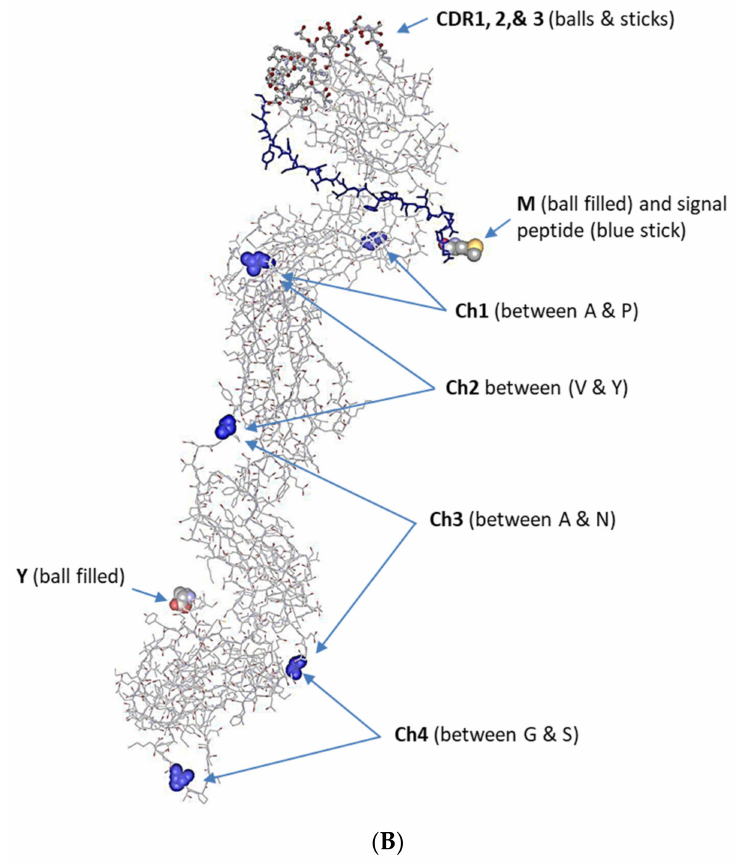
Figure 1. ( A ) Alignment of two full-length Ig M heavy chain peptides identified in this study (1A32 and 1A53) with a reference amino acid sequence (accession# A45804). Identical and missing amino acids are indicated by a dot (.) and dash (-), respectively. Signal peptide, variable domain (VH), joint segment (JH), constant domain (CH1, CH2, CH3 and CH4 segments) and C-terminal peptide are shown with arrows delineated. One amino acid substitution in the constant domain is marked with an asterisk (*). Three complementarity determining regions (CDR1–CDR3) are shown in shaded boxes and the diversity (D) segment is within the CDR3. ( B ) The 3-dimension structure view of IgM (1A32) with Swiss-Model. Highlighted are the first and last amino acids (M & Y), signal peptide, complementarity determining regions (CDR1–3) in the variable domain, and constant domain (segments